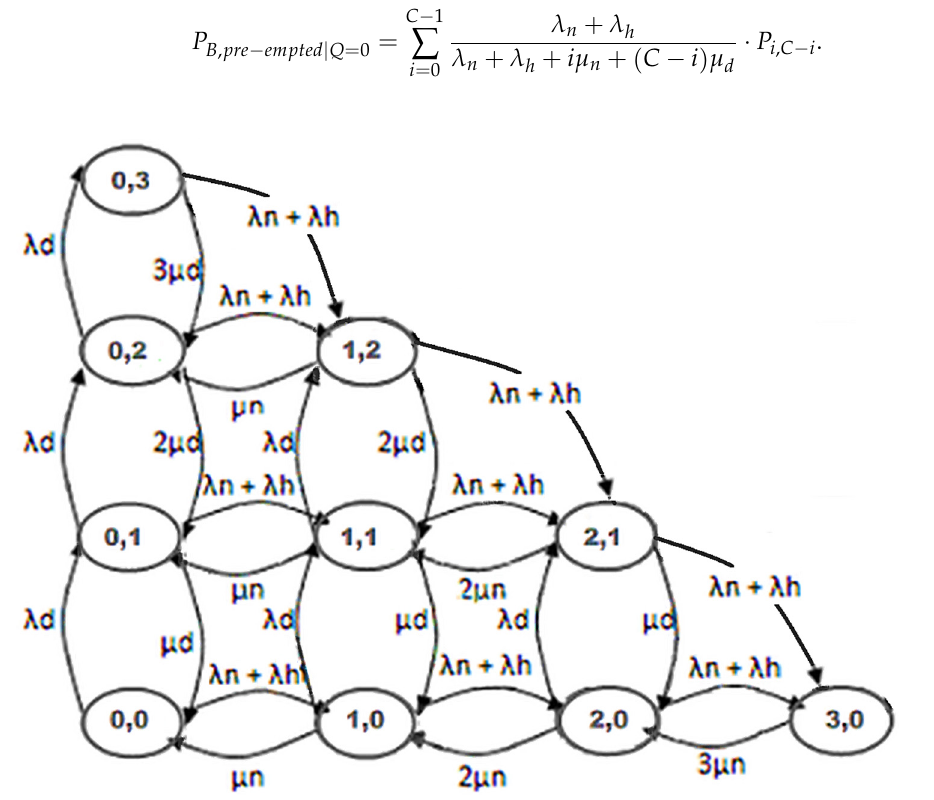
Figure 7. The state diagram (two ‐ dimensional Markov chain) for GSM/GPRS traffic without